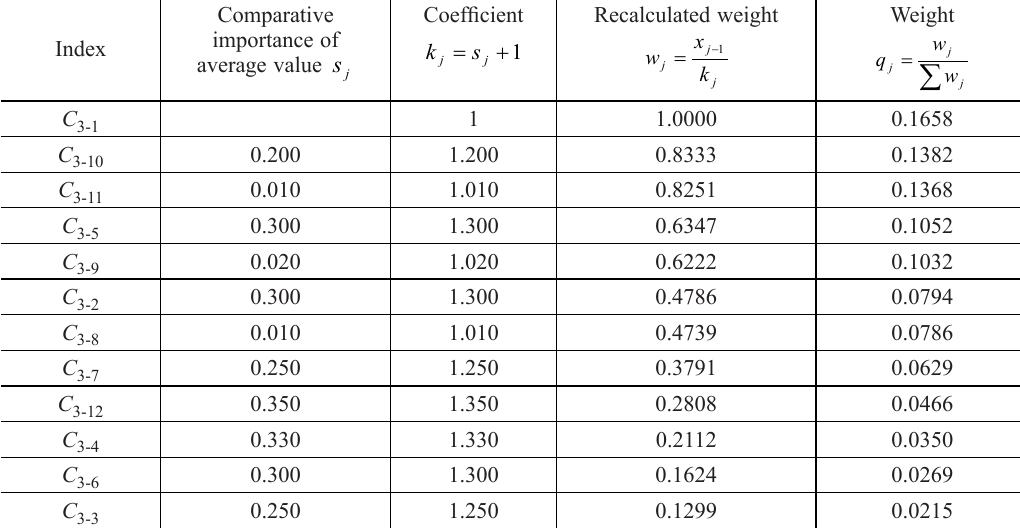
Table 7. Priorities and final weights of sub-indexes of the simplicity of implementation